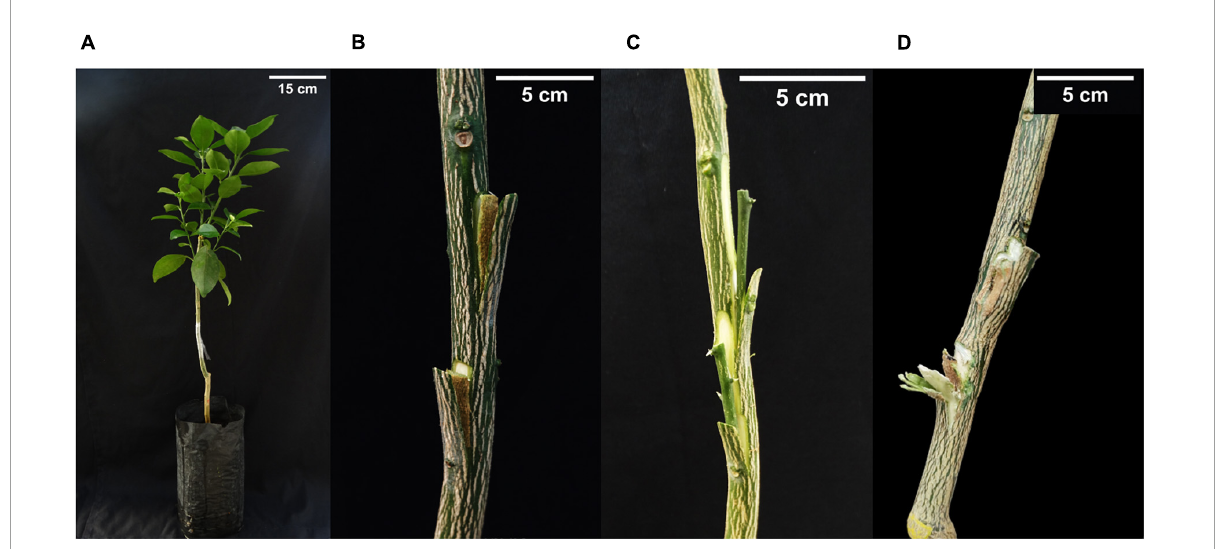
FIGURE2 Representative aspect (A) of a ‘Valencia’ sweet orange plant grafted with bark or budwood from the Oceanian citrus genotypes in Experiment 2; (B) of bark tissue taken from 5 cm below the graft union of Las-infected ‘Rangpur’ lime used as rootstock or from 8 cm above the graft union; (C) of budwood removed from the top of the Oceanian citrus genotypes; (D) and from a failed bark graft in experiment